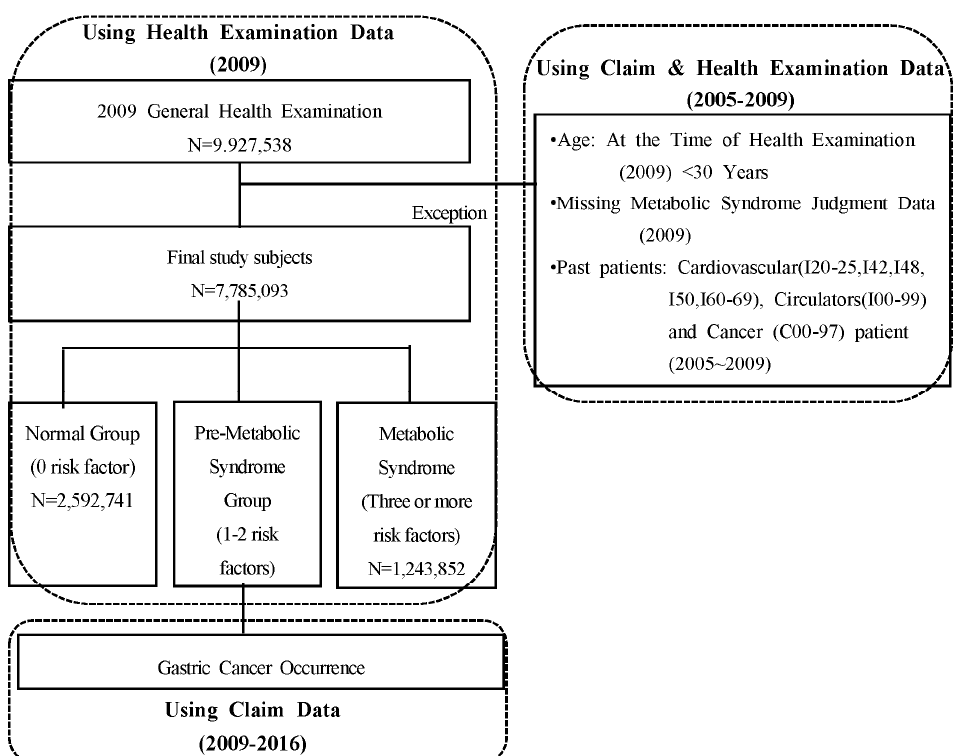
Table 1. Diagnostic criteria for the clinical diagnosis of metabolic syndrome.